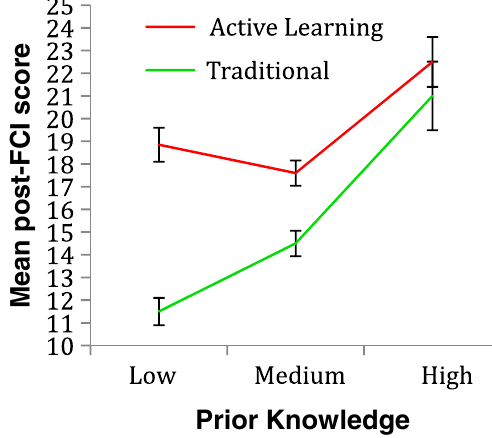
FIG. 4. Students in active learning student-centered pedagogies achieve higher post-FCI mean scores (ANCOVA adjusted for pre FCI) than students in traditional teacher-centered instruction. However, the difference in achievement for high prior knowledge students is not statistically significant. Error bars represent the standard error to the mean.